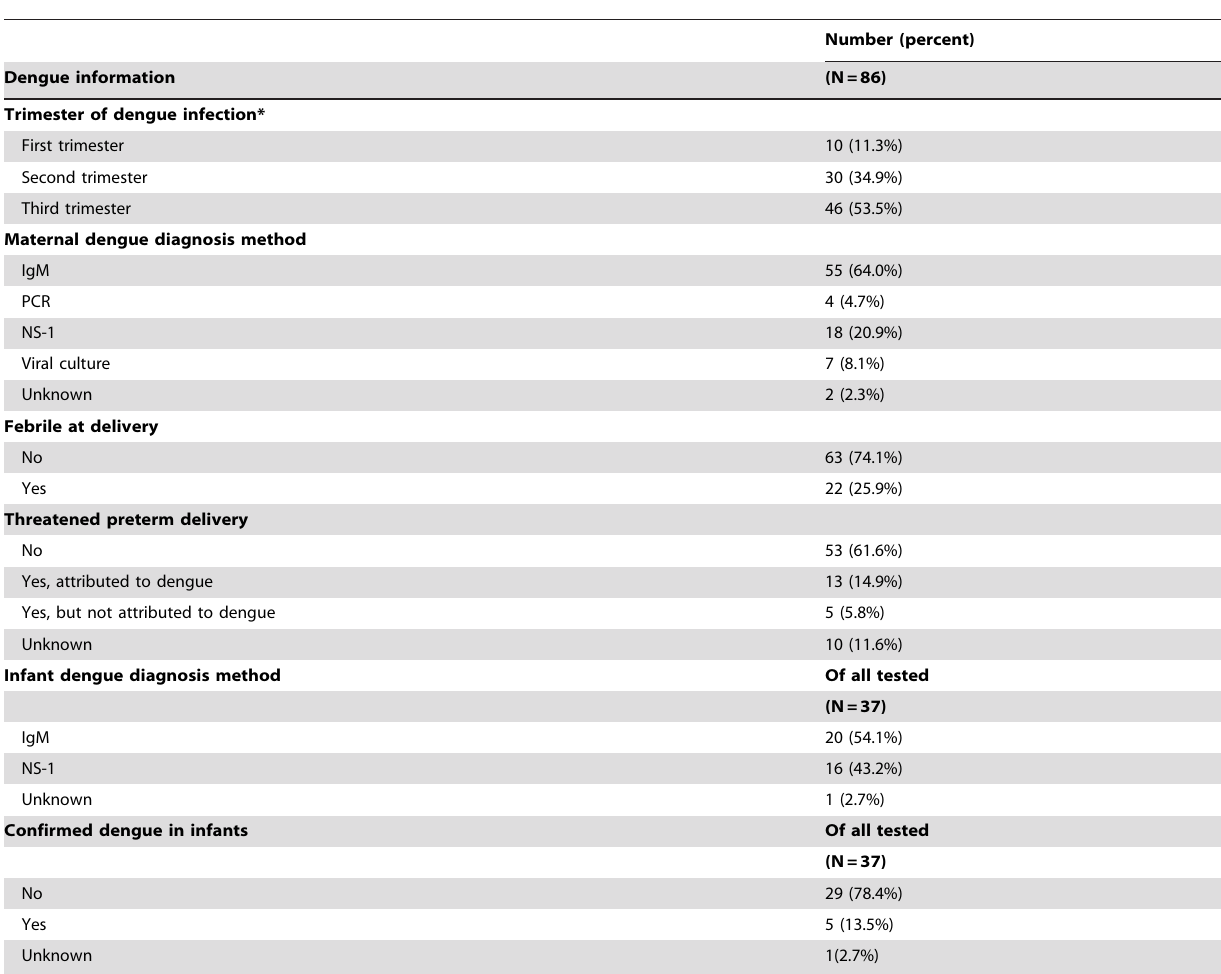
Table 3. Characteristics of symptomatic maternal and infant dengue